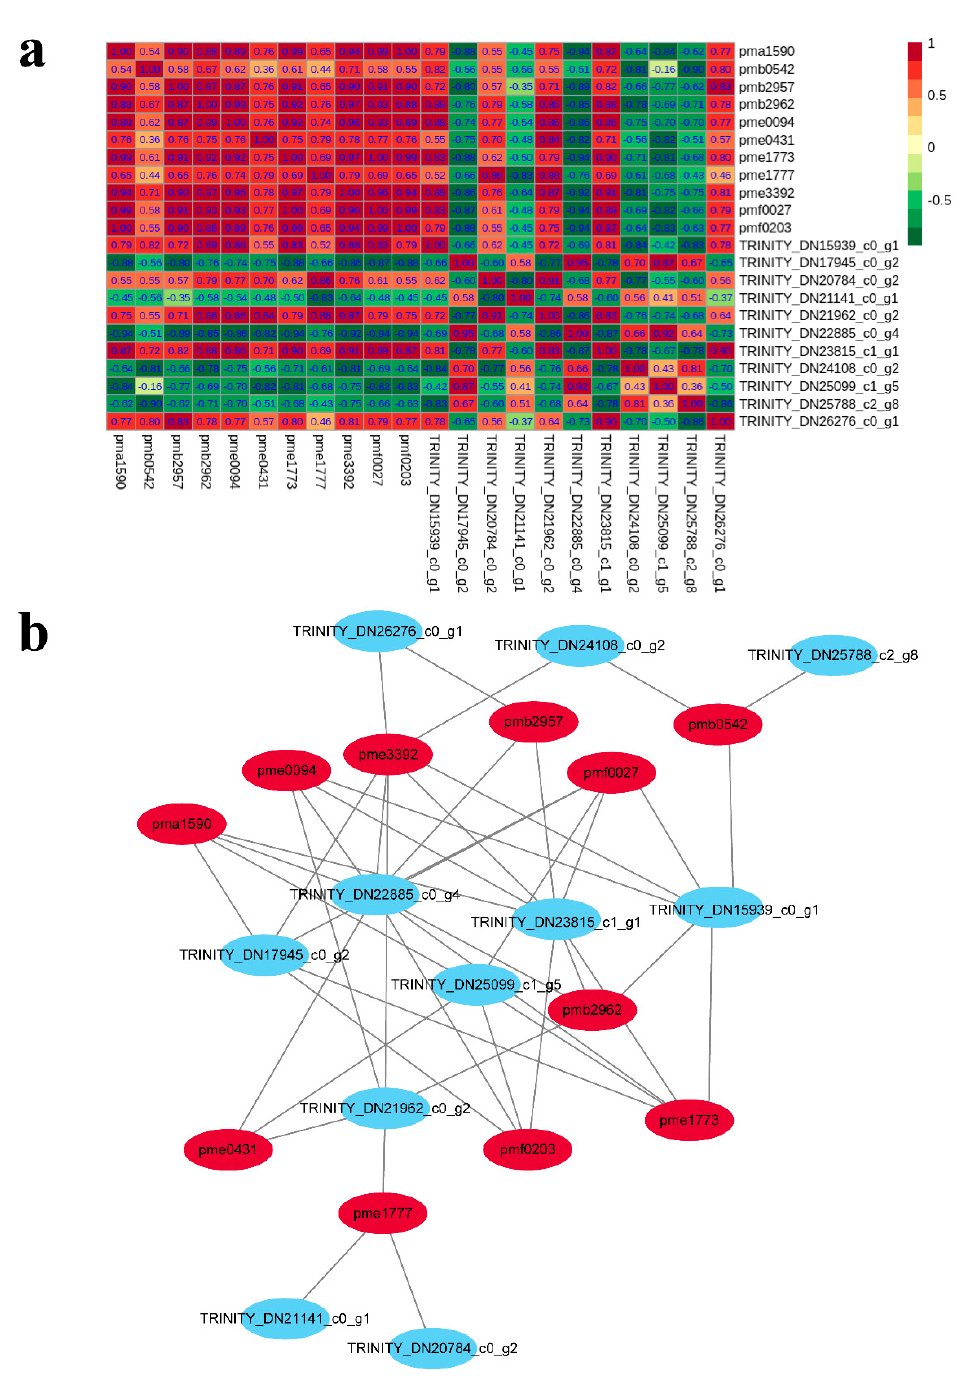
Figure 6. Correlation analysis of metabolites and DEGs. ( a ) Red indicates a positive correlation, green indicates a negative correlation. A deeper color indicates a stronger correlation. ( b ) Results of the correlation analysis between metabolites and DEGs. The networks between metabolites and transcripts were visualized with Cytoscape software. Gene ID including TRINITY_DN15939_c0_g1 (anthocyanidin synthase), TRINITY_DN17945_c0_g2 (phenylalanine ammonia lyase), TRINITY_DN20784_c0_g2 (4-coumarate–CoA ligase), TRINITY_DN21141_c0_g1 (4-coumarate–CoA ligase- like), TRINITY_DN21962_c0_g2 (Chalcone isomerase like), TRINITY_DN22885_c0_g4